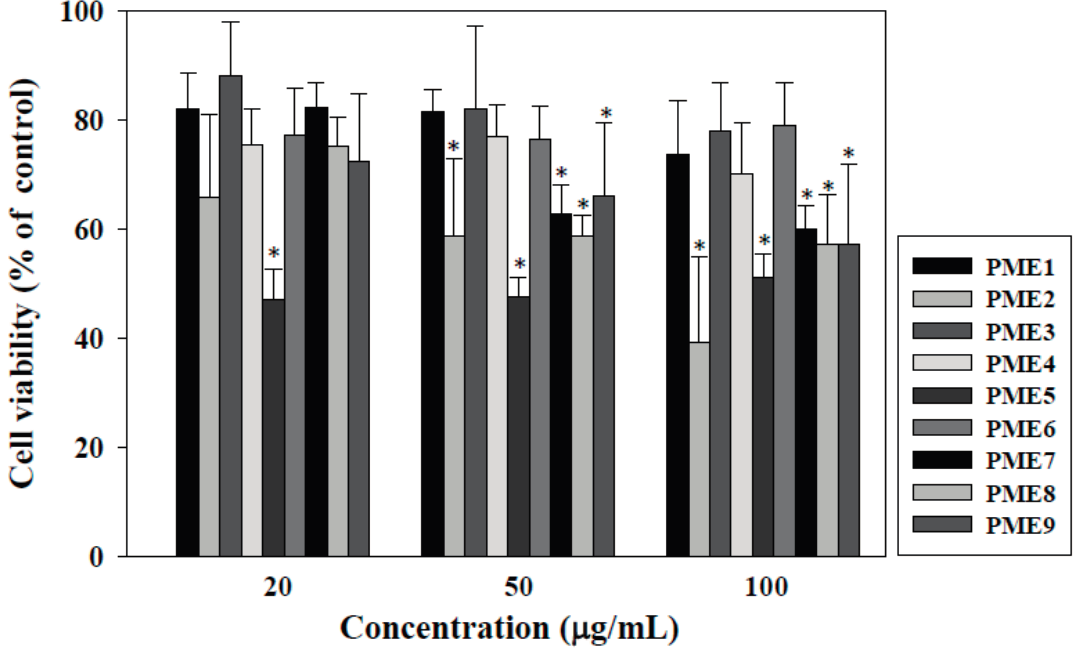
Figure 1. Effects of Pinus morrisonicola extract (PME) fractions 1 to 9 (PME1–9) on the viability of RAW 264.7 macrophages for 24 h. * indicate significantly different by comparison with the control ( p <